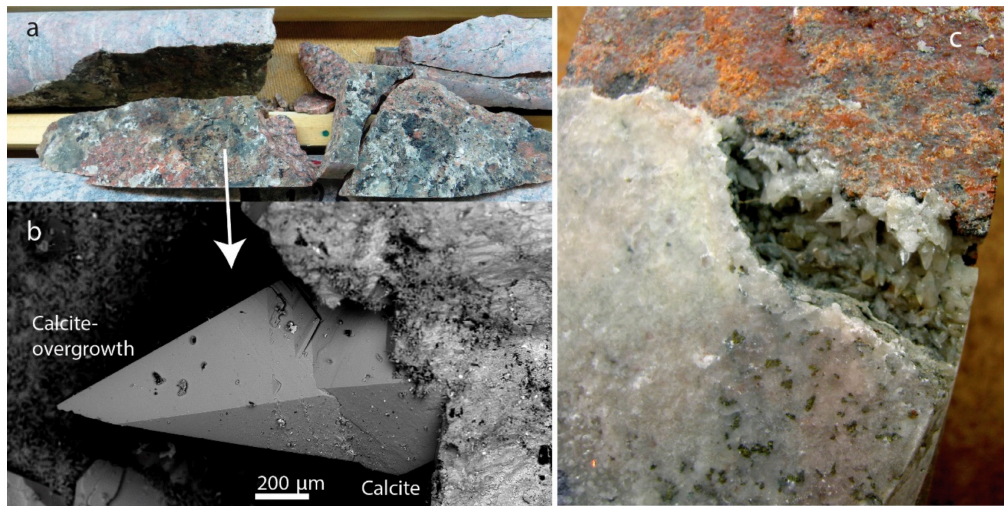
Figure 3. Calcite appearance in open fracture samples. ( a ) Drill core sample KFM01B:24 m from Forsmark showing the surface of an open fracture coated by calcite, pyrite, clay minerals, and bitumen. ( b ) Back-scattered SEM-image of sample KFM01B:24 m showing a euhedral calcite crystal with visible overgrowth of scalenohedral habit, ( c ) drill core sample KLX10C:122 m Laxemar-Äspö showing a partly open fracture with calcite crystals of scalenohedral habit coating the fracture walls. The drill core diameter is 5 cm, for scale ( a , c